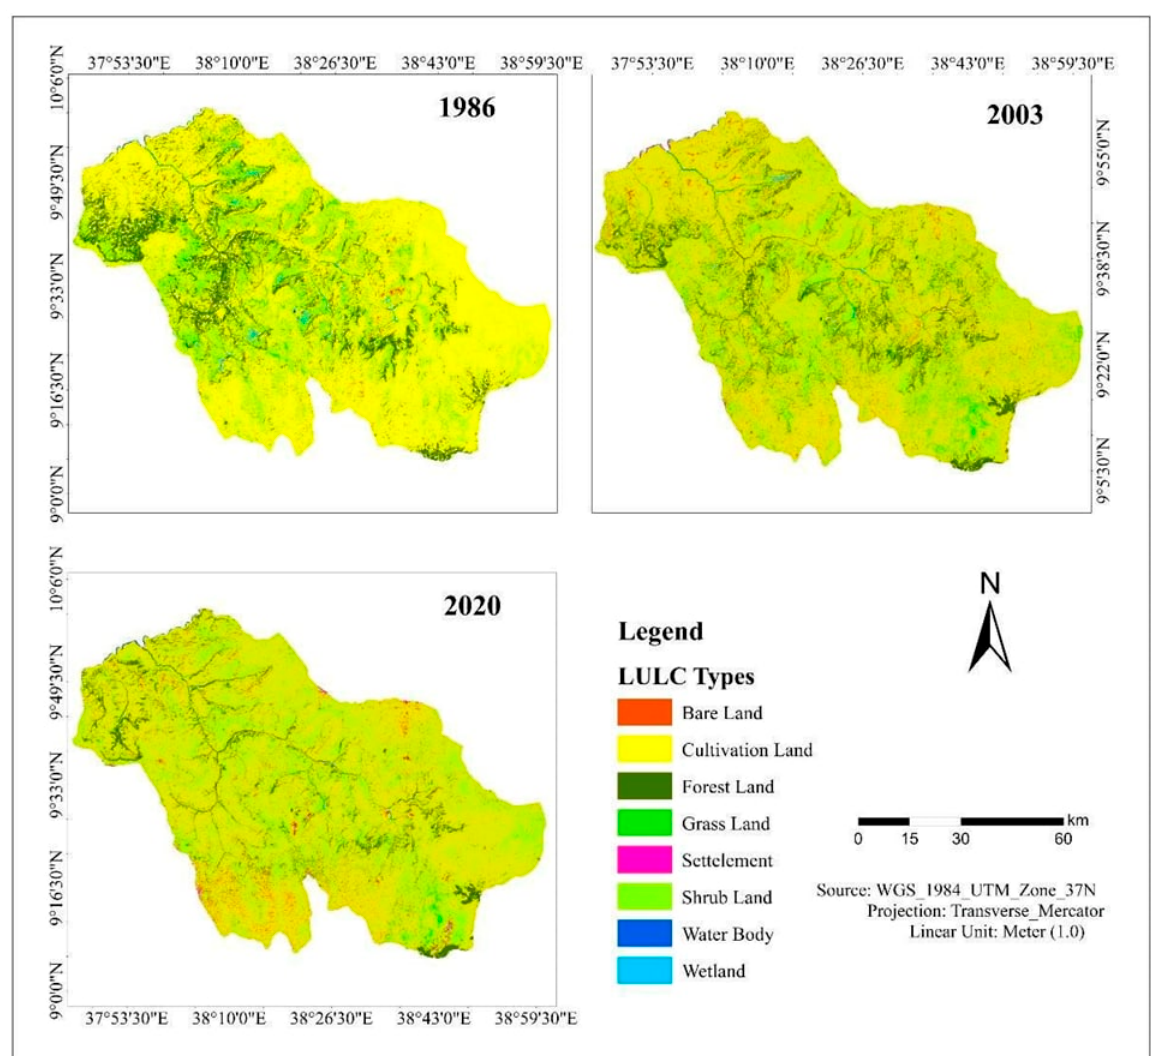
Figure 2. LULC map of Muger Sub-basin in 1986, 2003, and 2020 adapted from [48].